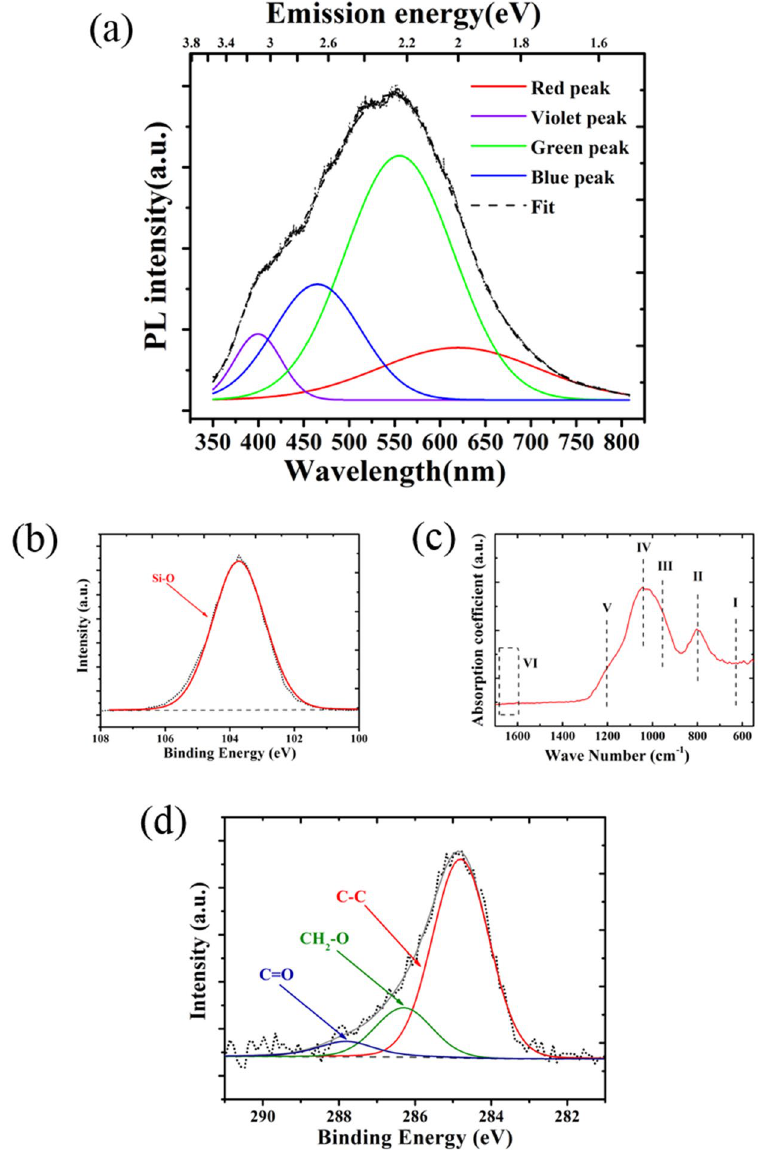
Figure 3. ( a ) PL spectrum of the laser-irradiated white-PL sample. The spectrum is deconvoluted into four PL bands. XPS analysis of the white-PL sample, showing the ( b ) Si 2p and ( c ) C 1 s spectra. ( d ) FTIR spectrum of the white-PL